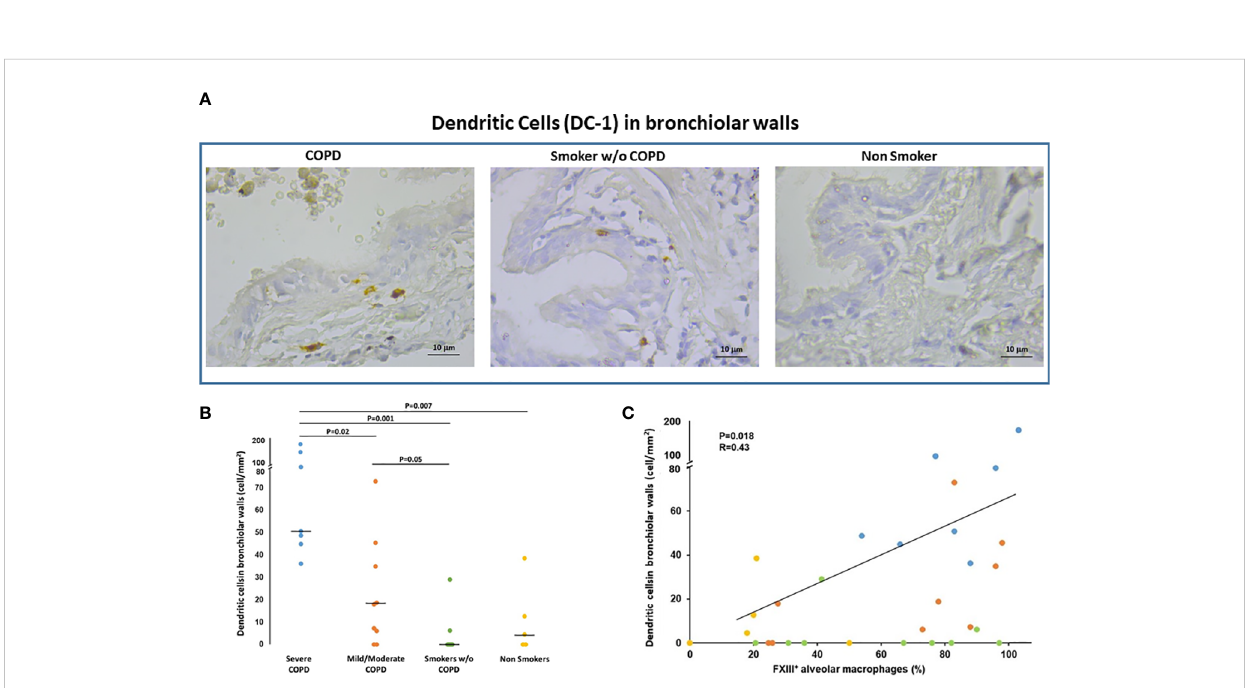
FIGURE 2 Dendritic cells (DC-1) in bronchiolar walls. (A) Immunohistochemistry of Langerin+ cells (DC-1) in bronchiolar walls in smokers with and without COPD and non-smokers. Langerin immunoreactivity appears as a diffuse brown color at the cytoplasmic level. (B) Number of DC-1 cells/mm 2 of bronchiolar wall in smokers with severe COPD (blue circles), mild/moderate COPD (orange circles), smokers without COPD (green circles) and non- smokers (yellow circles). Horizontal bars represent median values. Overall comparison by Kruskal-Wallis test (p<0.001) with Dunn ’ s multiple comparison test. (C) Correlation between the number of DC-1 in the bronchiolar walls and the percentage of AM expressing FXIIIA (r=0.43; p=0.018). Severe COPD Blue circles; mild/moderate COPD Orange circles; Smokers without COPD Green circles; Non-smokers Yellow circles.